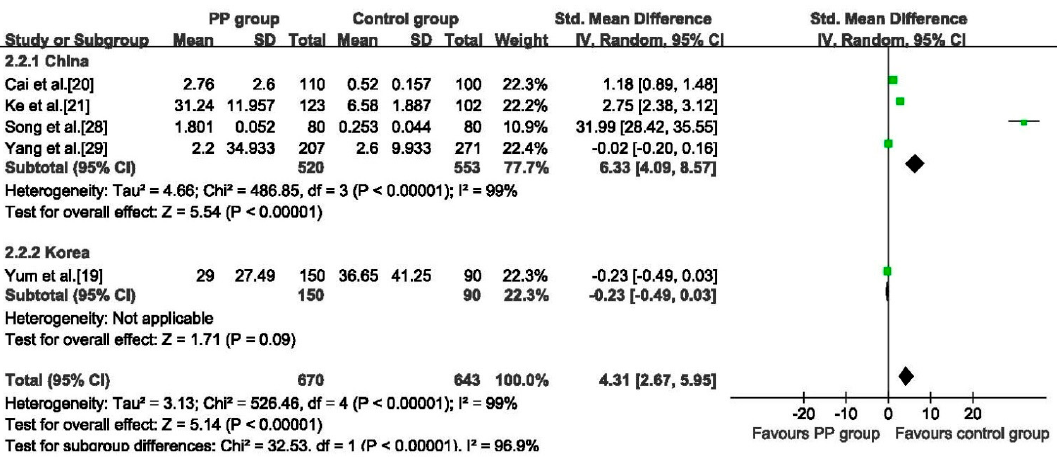
Figure 5. Forest plot for serum concentration of DBP between PP group and control group.